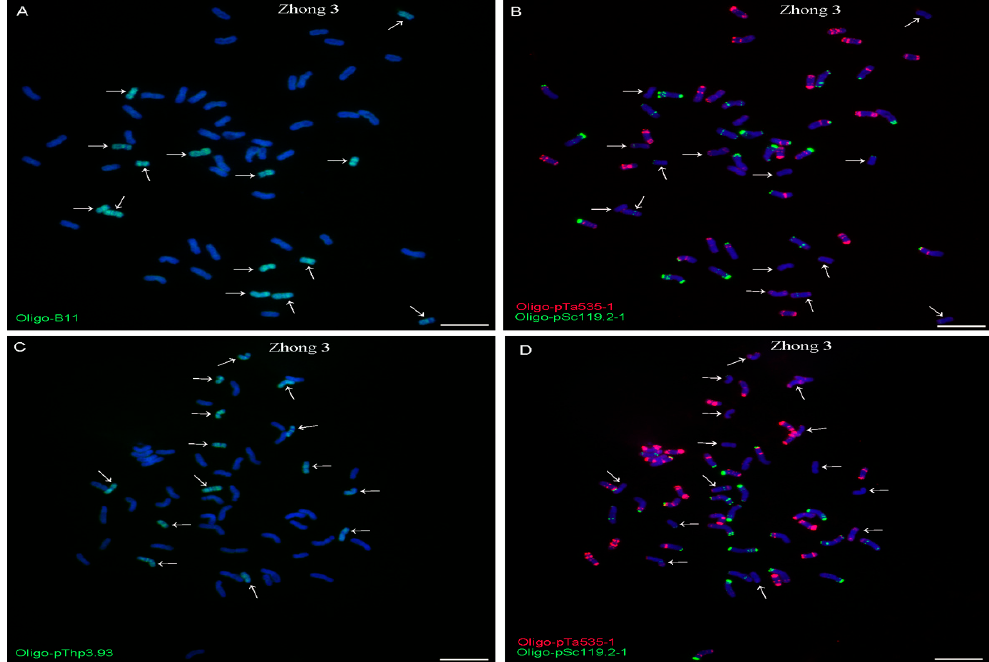
Figure 4. ND-FISH analysis of the root tip metaphase chromosomes of Zhong 3 using the Oligo-B11 (green), Oligo-pThp3.93 (green), Oligo-pTa535-1 (red) and Oligo-pSc119.2-1 (green) as probes. ( A ) and ( B ) are the same cell, and ( C ) and ( D ) are the same cell. Arrows indicate the Th. intermedium that carry signals of Oligo-B11 ( A ) and Oligo-pThp3.93 ( C ). Chromosomes were counterstained with DAPI (blue). Scale bar: 10 µ